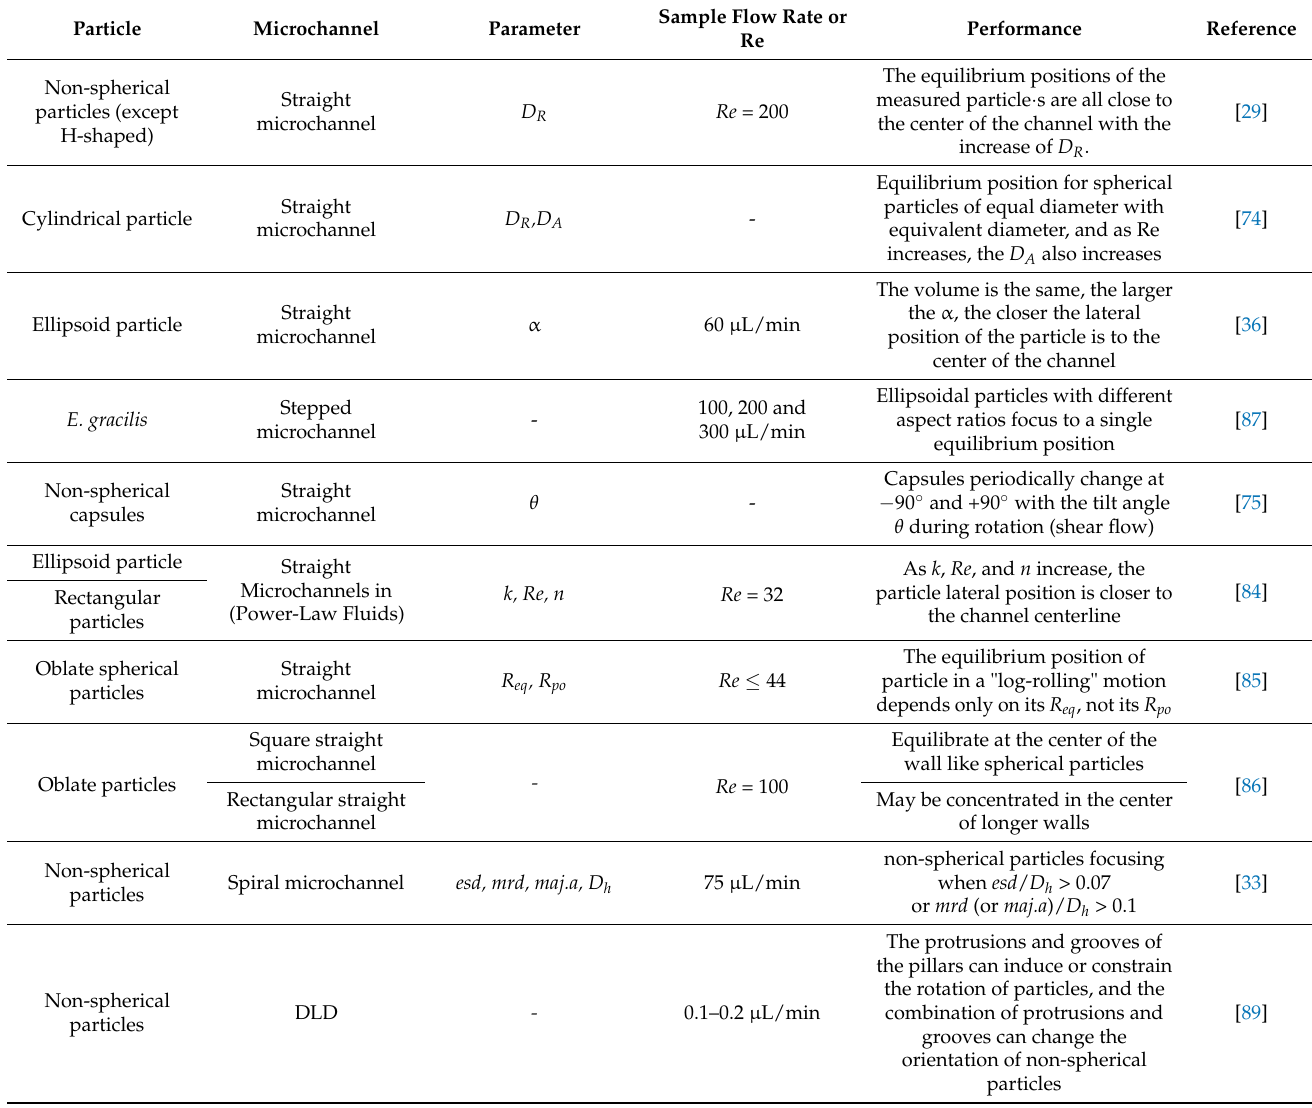
Table 2. Recent advances in passive manipulation of non-spherical particles in